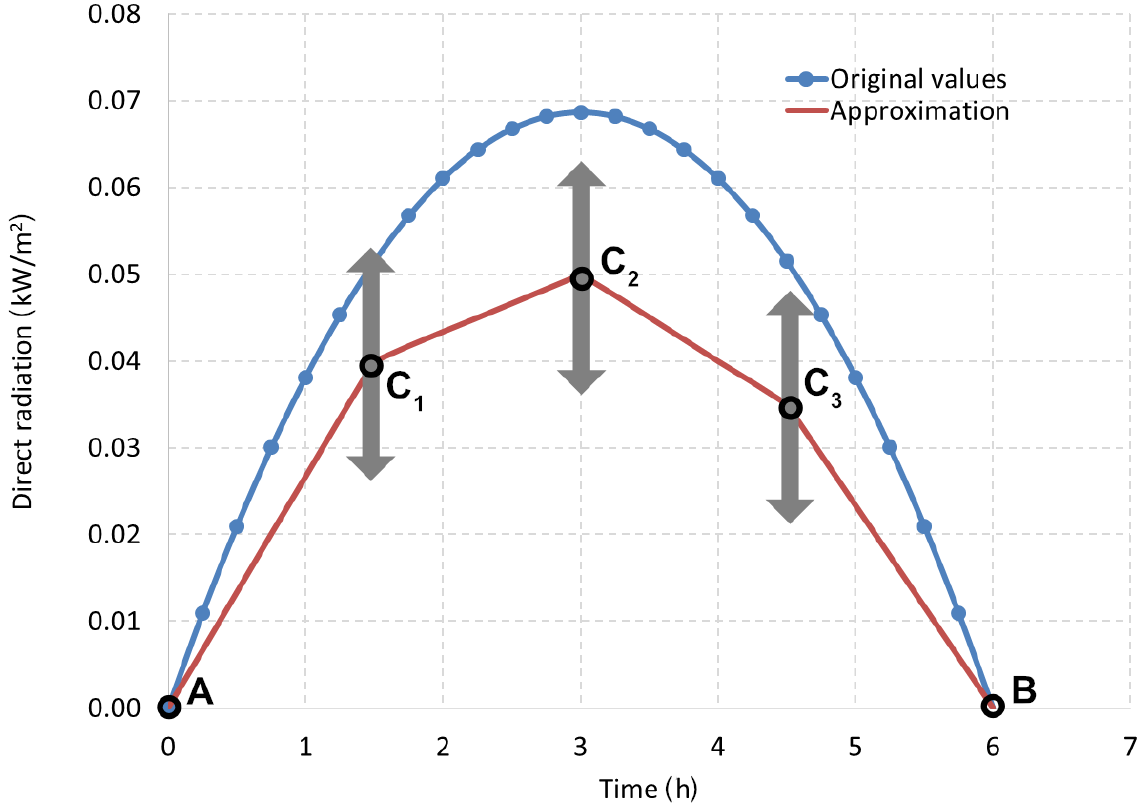
Figure 4. MEE scheme for three internal points (four